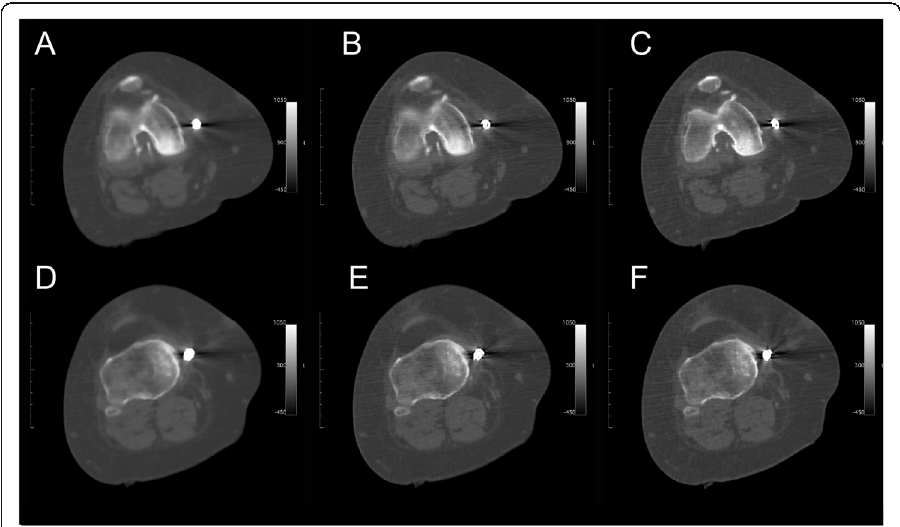
Fig. 6 Low-dose CT scan of a female patient (48 year) with an Atlas® Knee System in the right joint. Multiple reconstructions from the same CT detector raw data (120 kV, 55 mA, t rot = 0.8 s, pitch = 1.375). Reconstruction is shown for the region of femur ( a ‑ c ) and the tibia ( d ‑ f ). CT reconstruction was performed with setup a , d “ S Plus ” (slicing = 3.75 mm), b , e “ B+ Plus ” (slicing = 3.75 mm), and c , e “ Bone Plus IQE ” (slicing 1.25